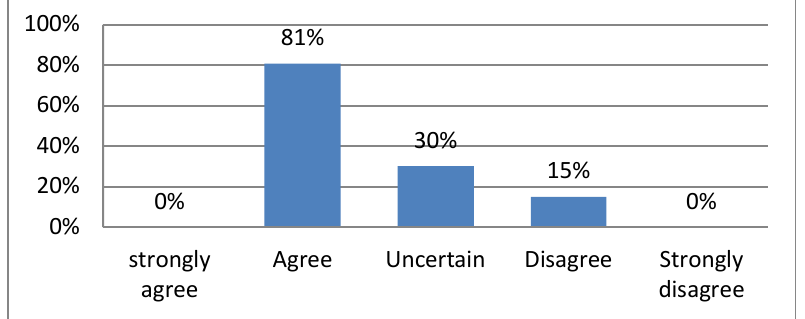
Figure 11 : role of advertisement.